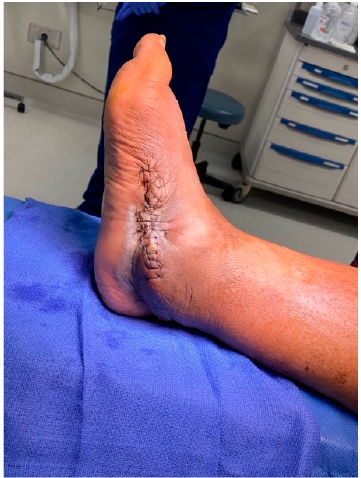
Figure 5. Final wound closure.